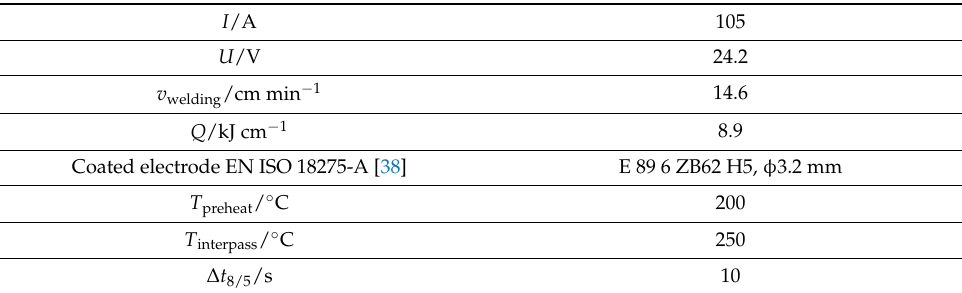
Table 2. Welding parameters for real welding.